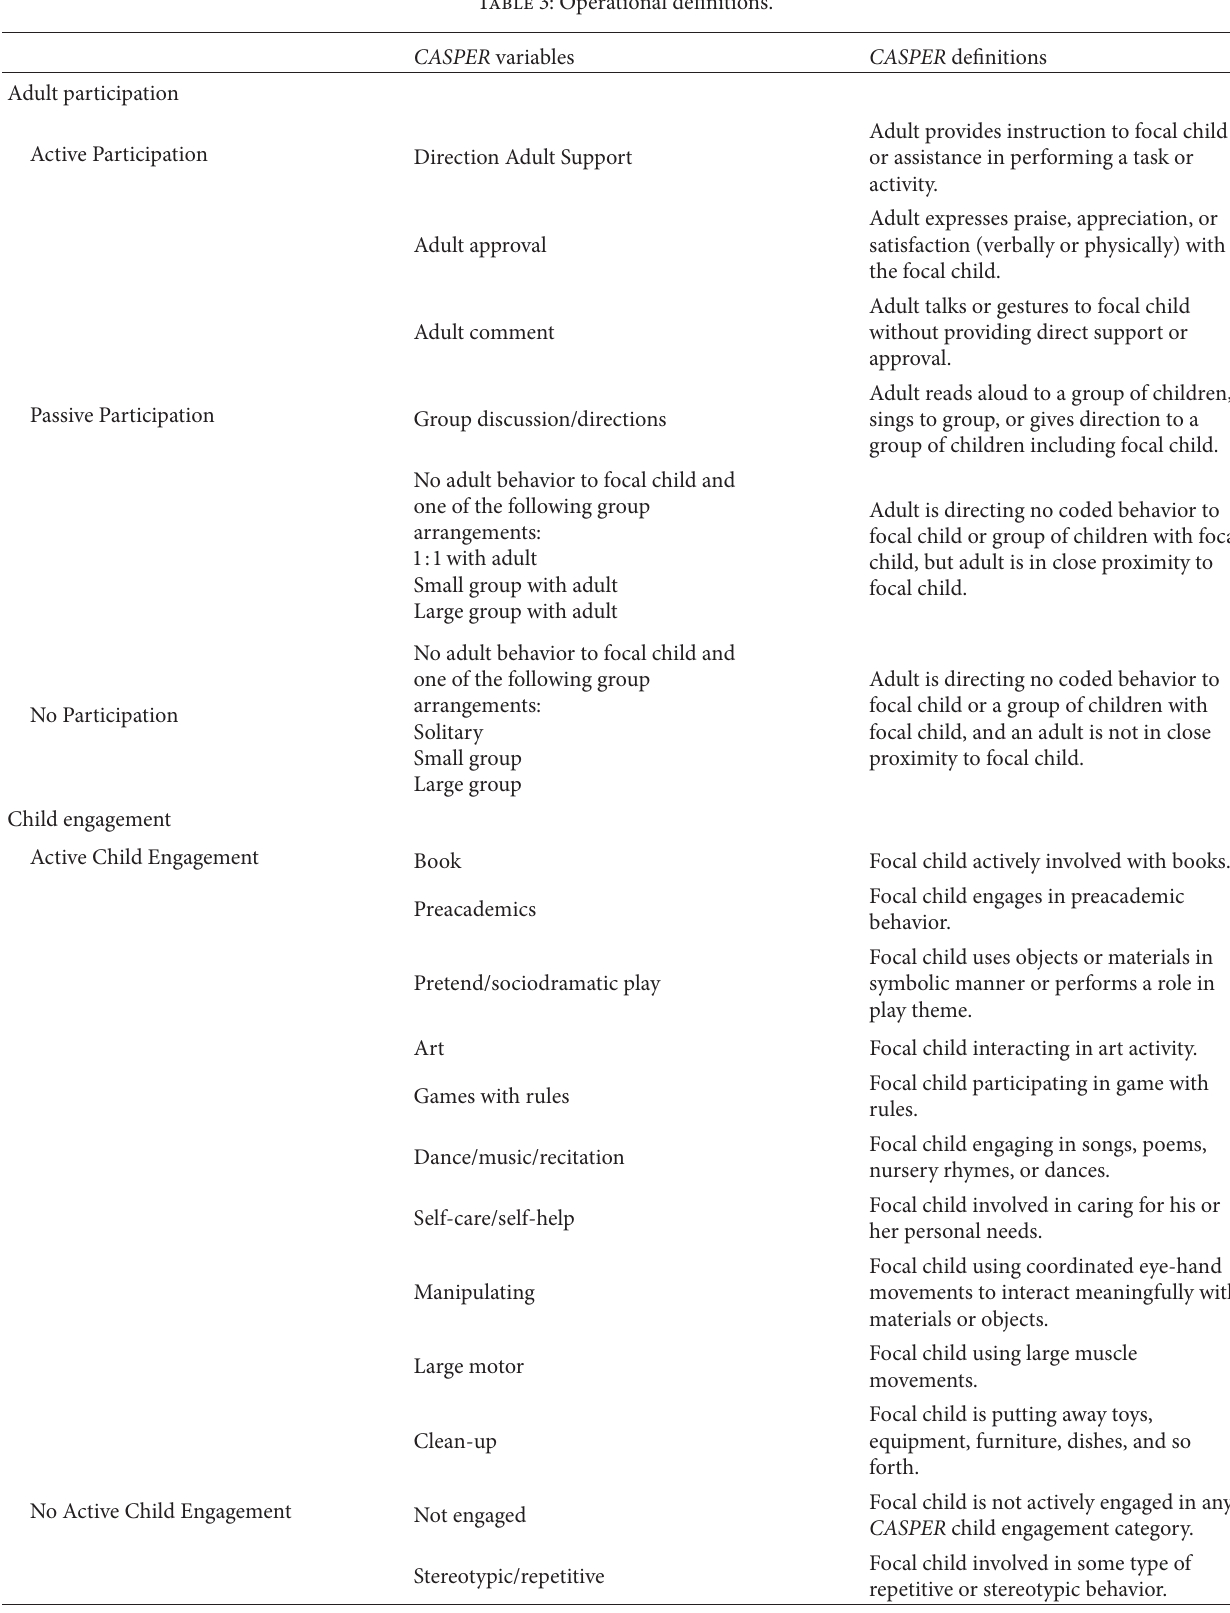
Table 3: Operational